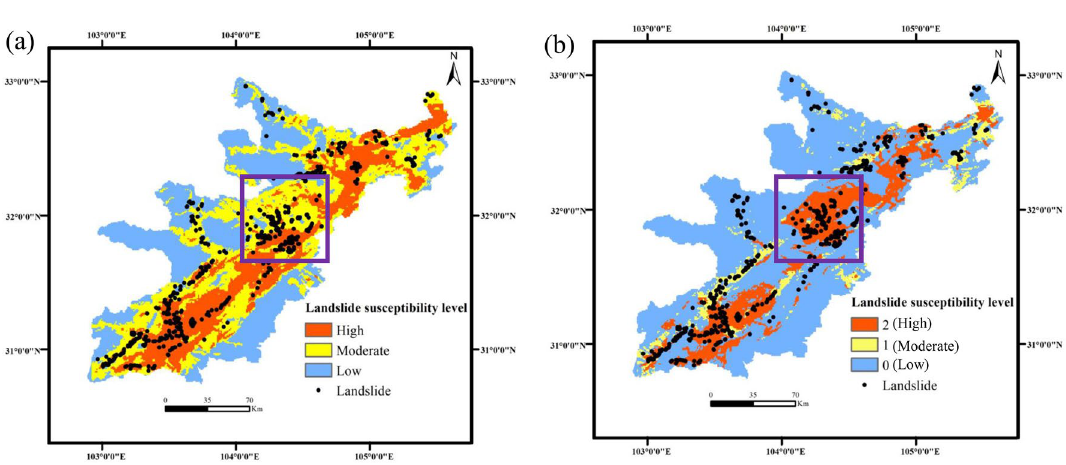
Figure 7. Spatial distribution of the prediction results of landslides in extremely earthquake-stricken areas: ( a ) Landslide prediction distribution map based on the two-category LR-based landslide prediction model; ( b ) Landslide prediction distribution map based on the KDE-MLR model (Names of software: ArcGIS 10.5 and Office